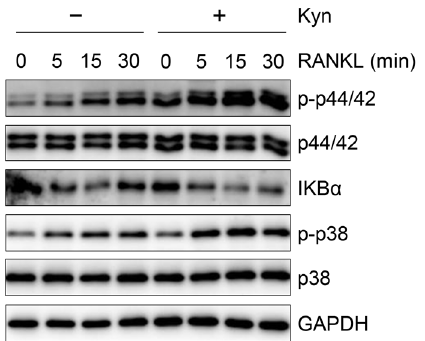
Figure 5. Kyn does not inhibit RANKL-induced signaling in OCPs. Human PBMC CD14+ cells were cultured with M-CSF (20 ng/mL) for 2 days. The OCPs were treated with Kyn (100 µ M) for 3 h, and then the cells were stimulated with RANKL (40 ng/mL) for the indicated time.